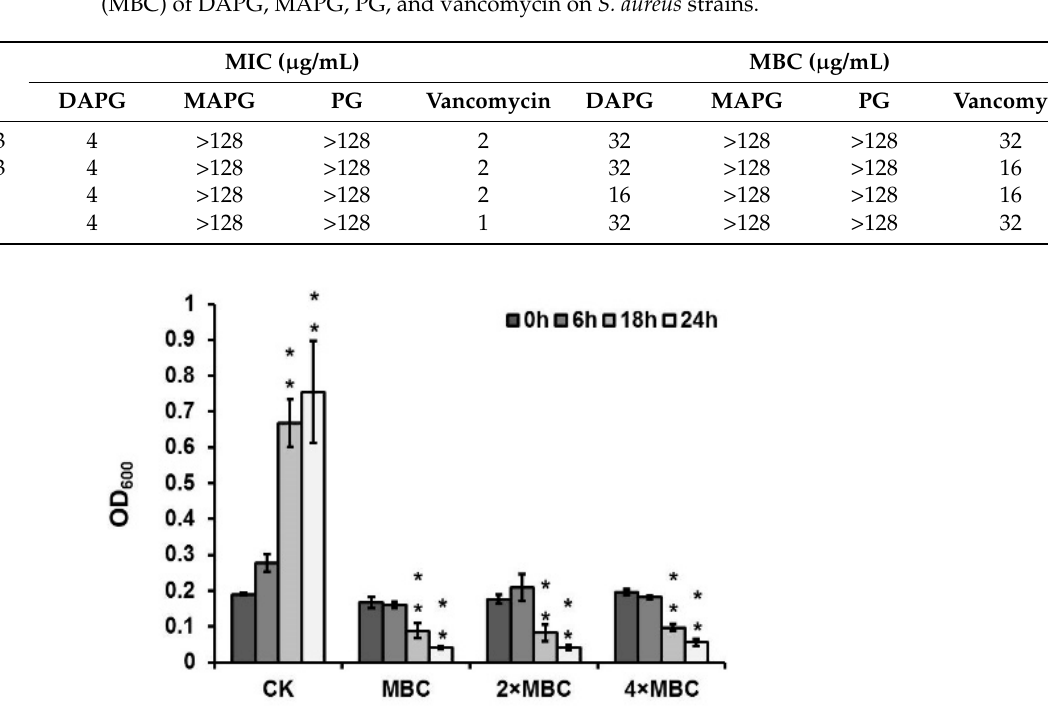
Figure 3. Bacteriolytic activity of DAPG against S. aureus Sta24-1 at 1 × MBC (32 µg/mL), 2 × MBC (64 µg/mL) and 4 × MBC (128 µg/mL). The S. aureus Sta24-1 was exposed to DAPG with different concentrations at the early stage of exponential growth, and the negative control (CK) was exposed to methanol. The optical density (OD 600 ) was measured at 0, 6, 18, and 24 h after incubation with DAPG. Mean values of three replicates are given, and error bars indicate standard error. ** indicates p < 0.01. Table 4. The minimum inhibitory concentration (MIC) and minimum bactericidal concentration (MBC) of DAPG, MAPG, PG, and vancomycin on S. aureus strains. Strains